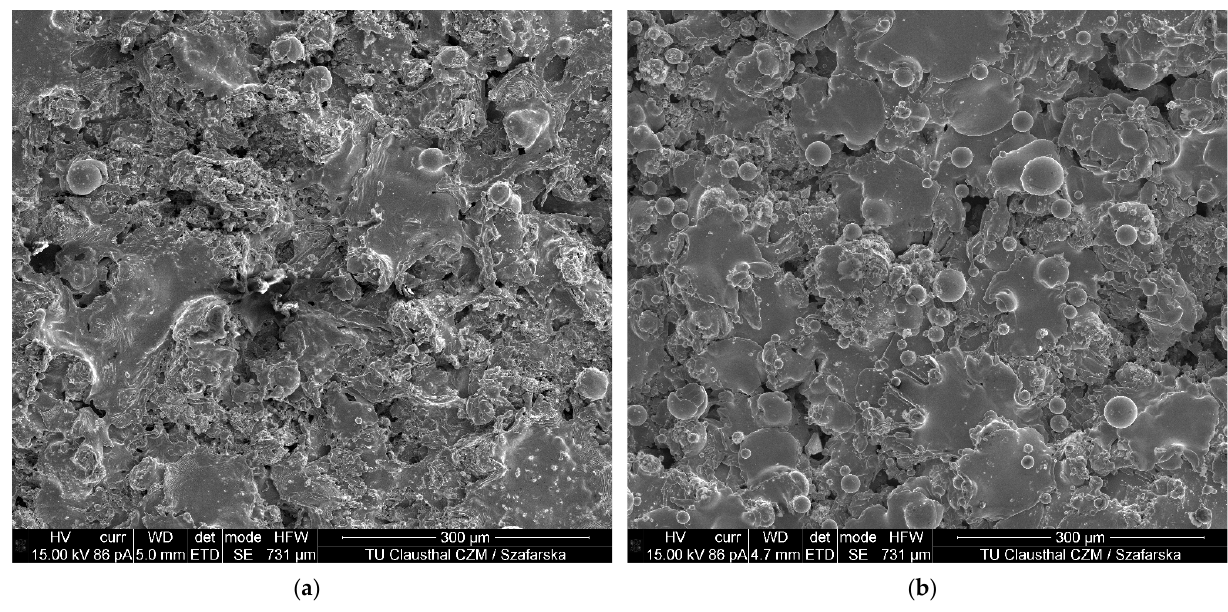
Figure 10. SEM micrographs of the surfaces of wire arc copper coatings: ( a ) conventionally coated in air; ( b ) coated in silane ‐ doped nitrogen.